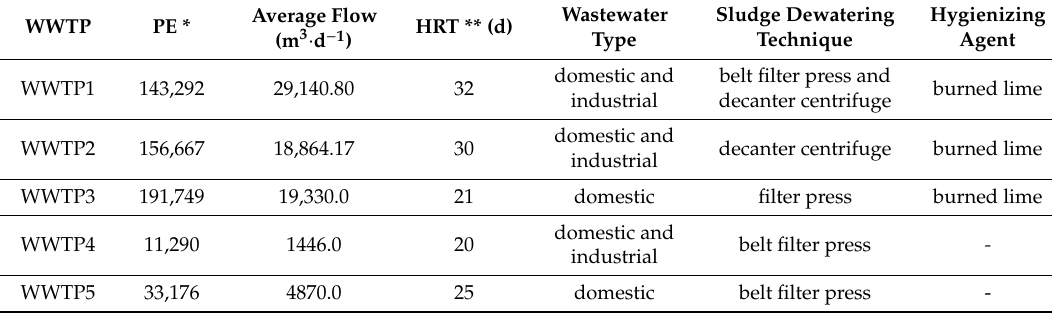
Table 1. Operational parameters of the WWTPs.